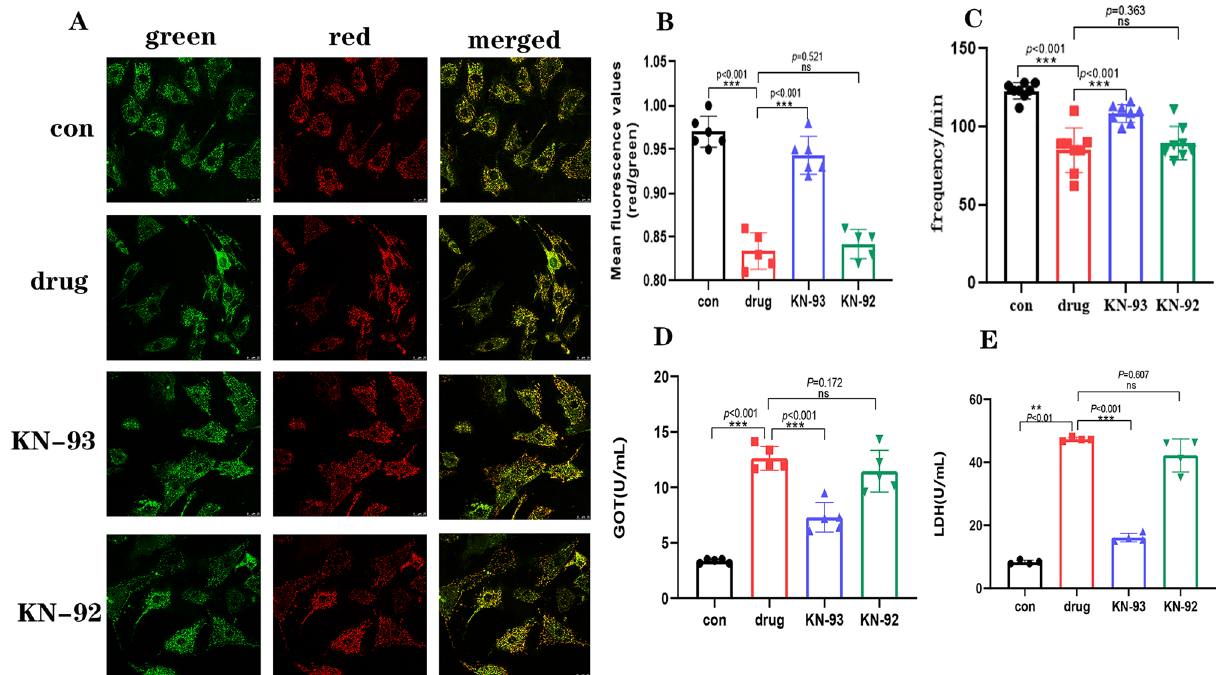
Figure 1. Effect of KN-93 on diacetylmorphine-induced cardiomyocyte injury in vitro. ( A ) Representative immunofluorescence images of JC-1 fluorescent probe showing the effects of diacetylmorphine and KN-93 and KN-92 on the mitochondrial membrane potential of cardiomyocytes. ( B ) Quantitative plot of A, mean ± SD. ( C ) Histogram of cardiomyocyte beat frequency for each group, mean ± SD. ( D – E ) LDH and GOT activity detection. All data are expressed as mean ± SD, * P < 0.05, ** P < 0.01, *** P < 0.001, **** P < 0.0001, ns: P >